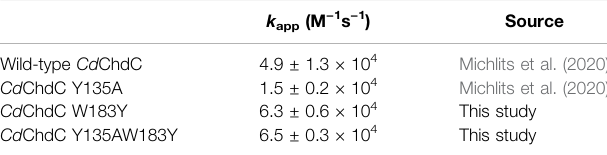
TABLE 2 | Pre-steady-state kinetic rate constants of compound I formation in Cd ChdC and